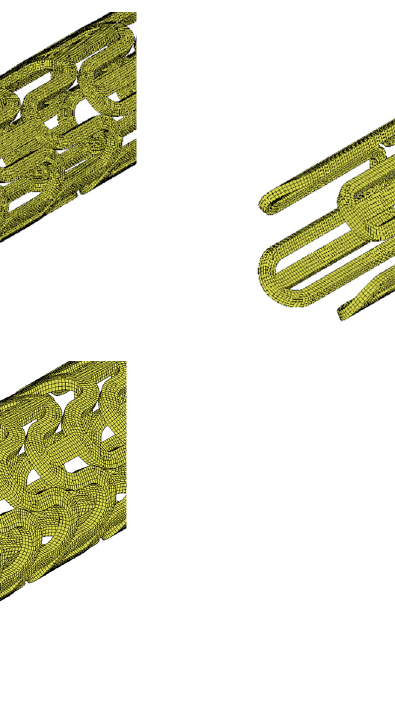
Figure 5. Discretized models of stents: ( a ) optimal, ( b ) too long, ( c ) too short .